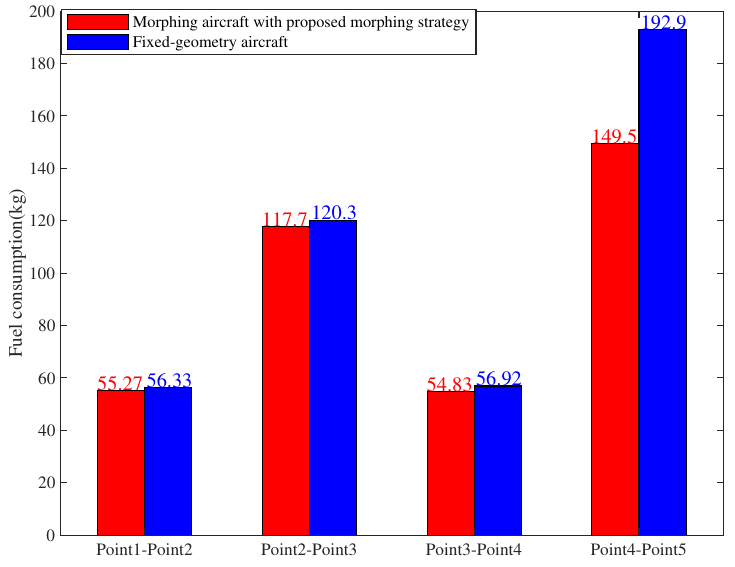
Figure 15. Fuel consumption for each cruise phase of the comparative simulation in Section